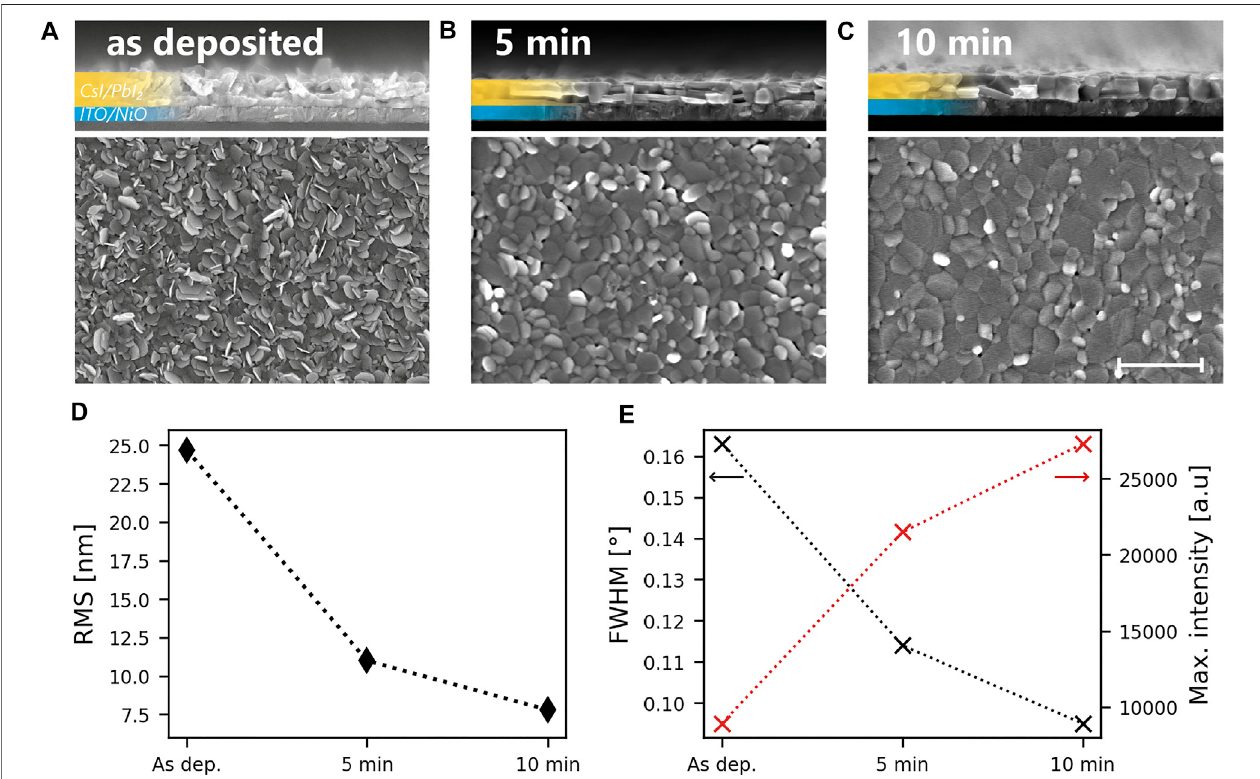
FIGURE 2 | Effect of annealing in the CVD system on the precursor. SEM cross section, top view as well as AFM scans of a CsI/PbI 2 precursor deposited on NiO annealedat300 ° Cinits (A) pristinestateandafter (B) 5and (C) 10 minofannealingintheCVDsystem(170 ° C,7 mbar).Thescalebarshowsalengthof1 μ mandapplies to all SEMimages (D) RMS roughness extracted from AFM measurements conductedon the asdeposited and the annealed precursor. (E) Full-width-at-half-maximum and maximum intensity of the (001) diffraction peak of PbI 2 of the layers in (A – C) .